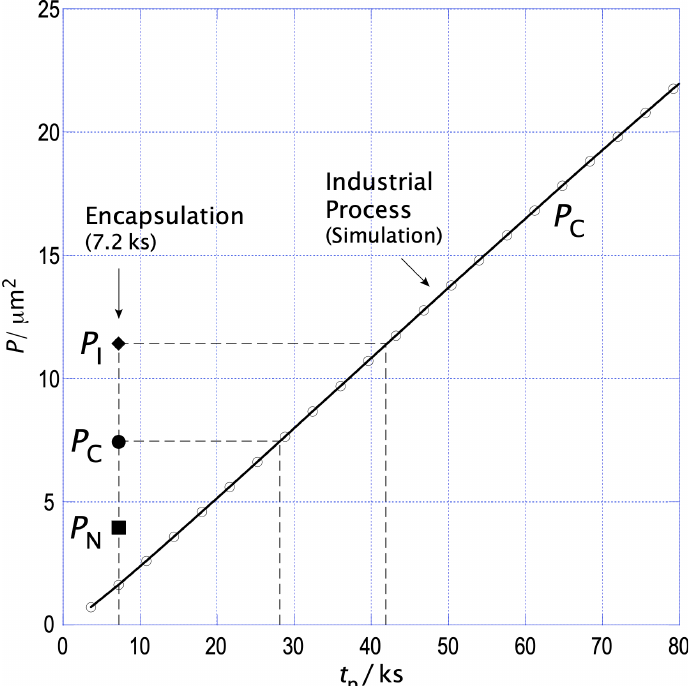
Figure 10. Interstitial solute penetration P , defined in (5), as a function of processing time t p . The solid data points marked by P N , P C , and P I refer to the Encapsulation Method, indicating P for nitrogen, carbon, and both interstitial solutes (nitrogen and carbon combined), respectively. The hollow circular data points, connected by a continuous line, show simulated P C data for the industrial process